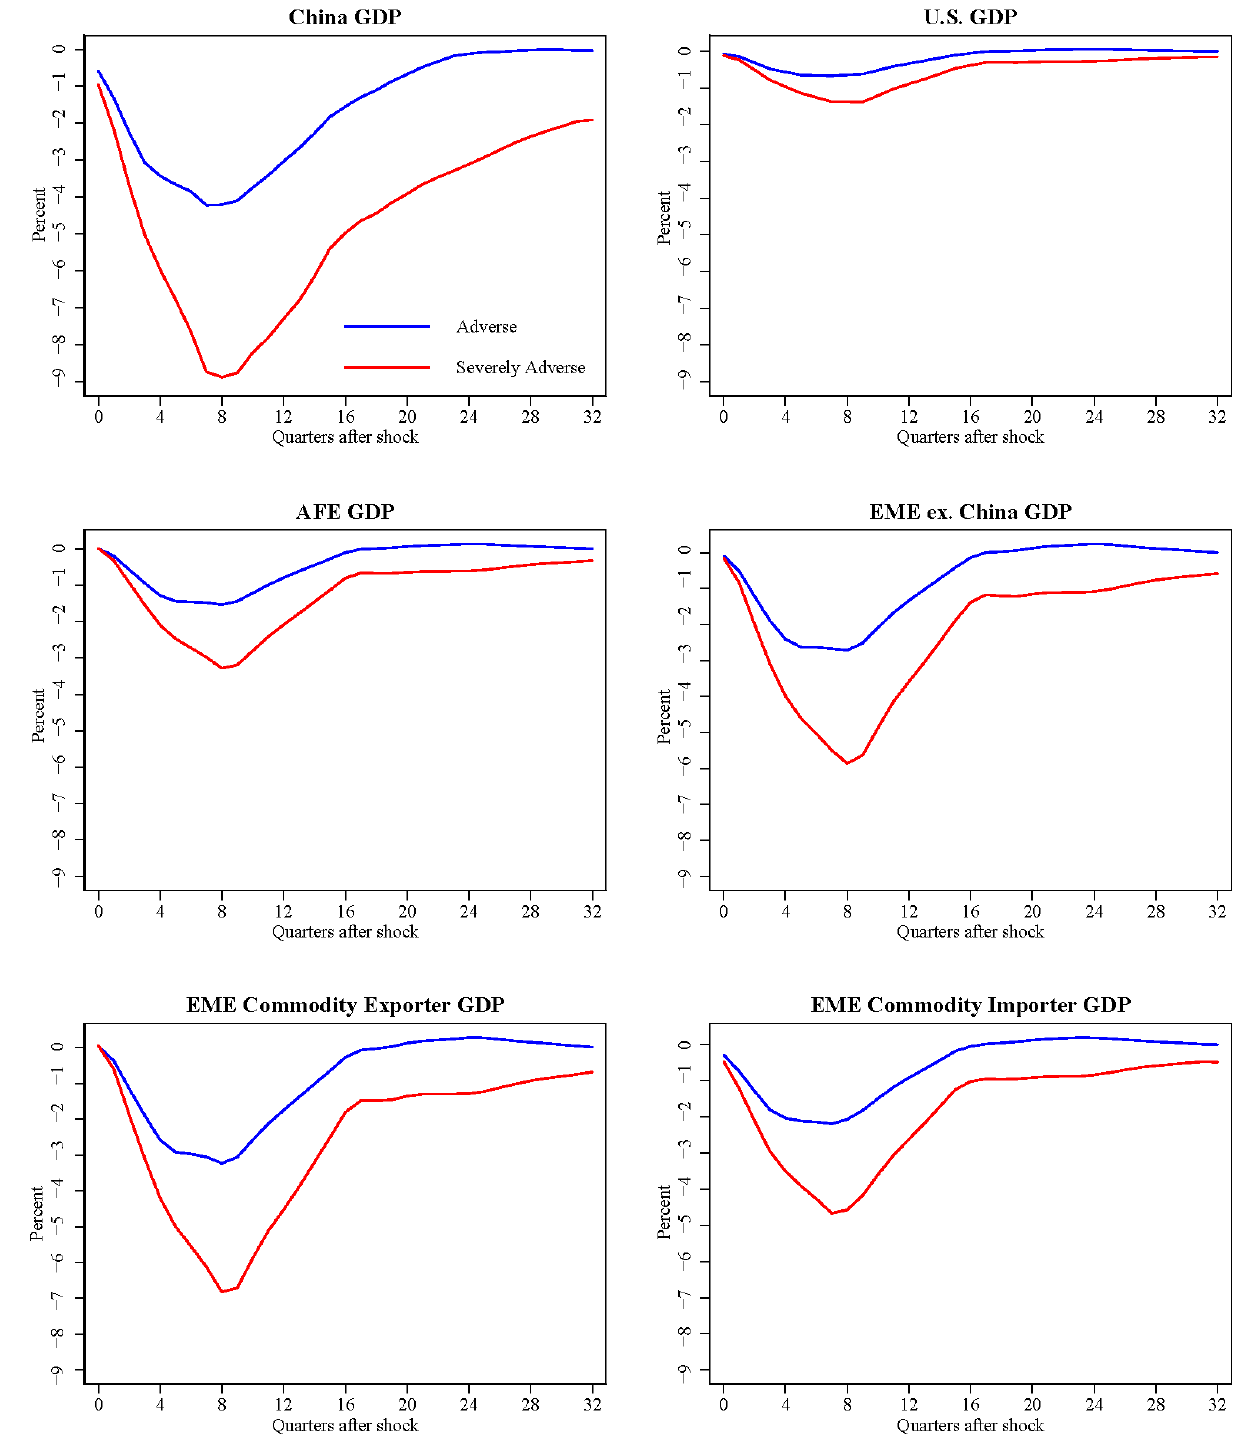
Figure 7. Activity responses to China GDP scenarios. Source: authors’ calculations using data from Haver Analytics and Bloomberg.